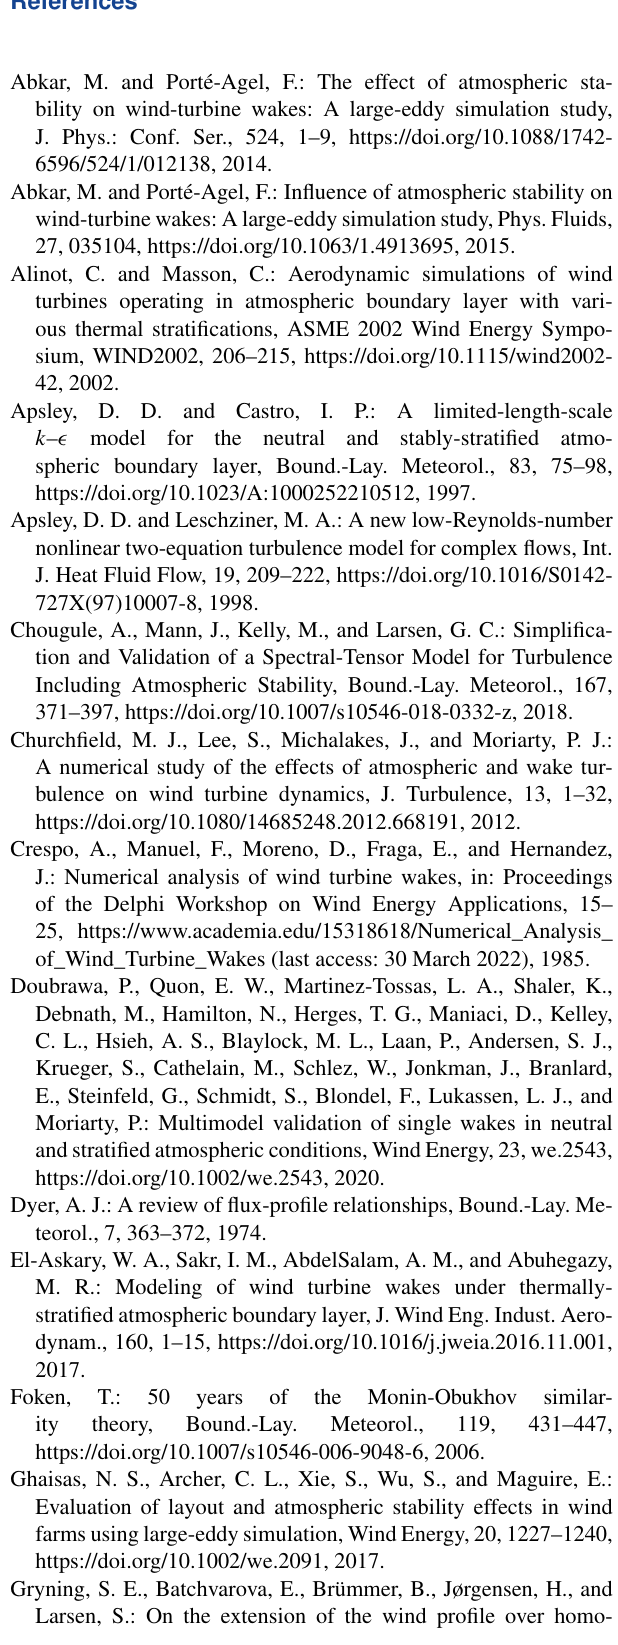
Fig. A4. For reference, a neutral k – ε – f P simulation with the same inflow speed and TI is simulated. The 2017 model per- forms poorly in the sense that it actually recovers slower than the neutral reference and that no equilibrium wake–wake in- teraction seems to occur. On the other hand, the cstB model predicts faster wake recovery for the first three to four tur- bines, while it goes to the same wake deficit as the